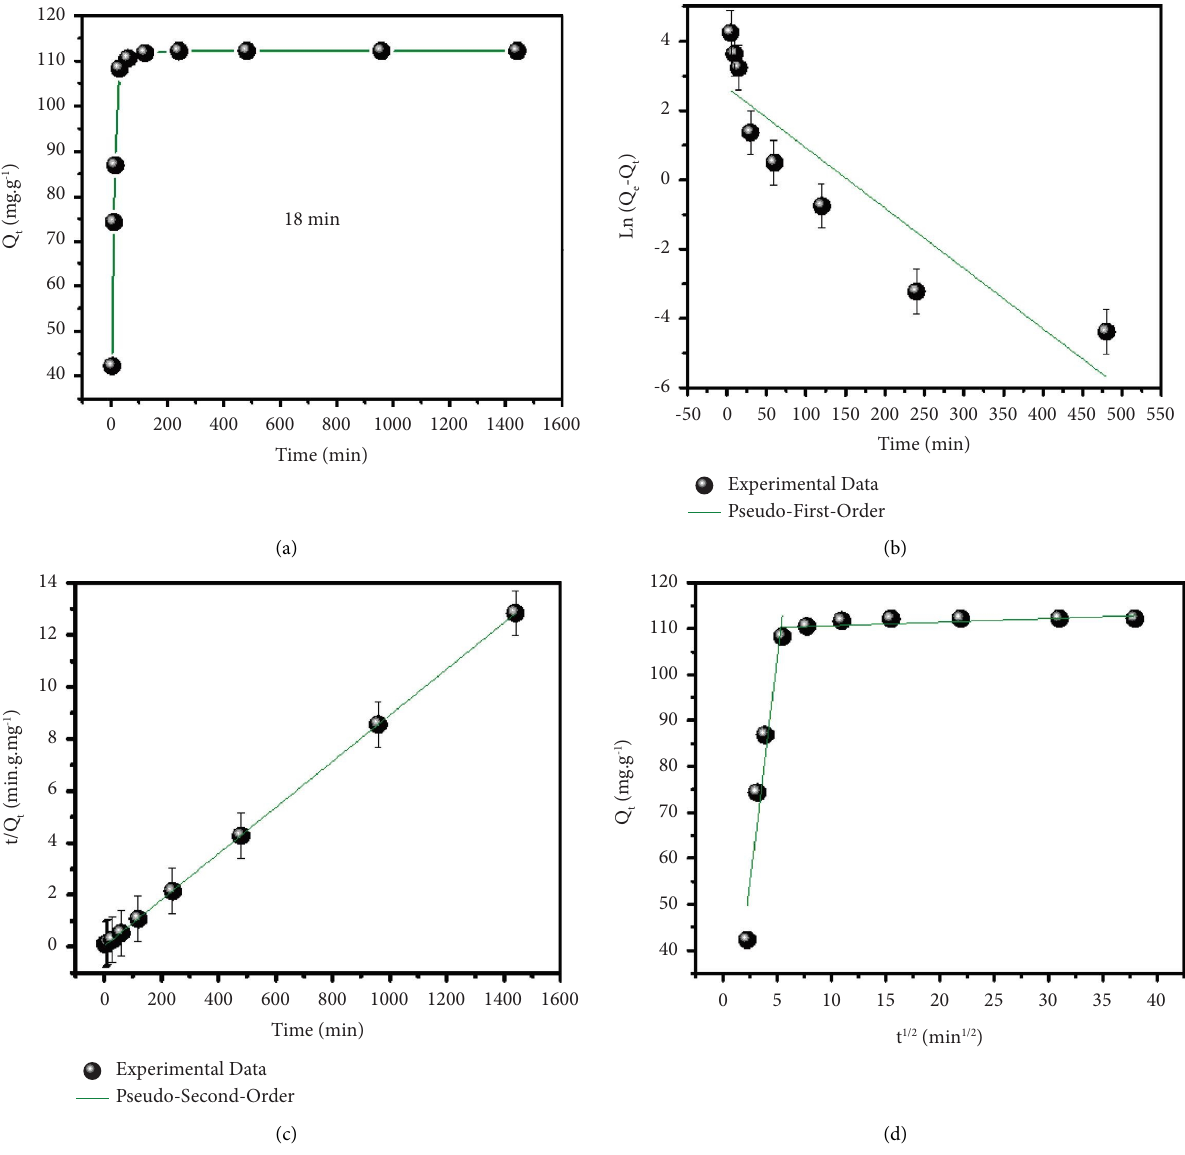
Figure 6: Efects of duration time (a), PFO (b), PSO adsorption kinetics models (c), and intraparticle difusion of Co (II) onto CaO.MgO nanosorbent. Table 1: Kinetics models for Co (II) adsorption onto CaO.MgO